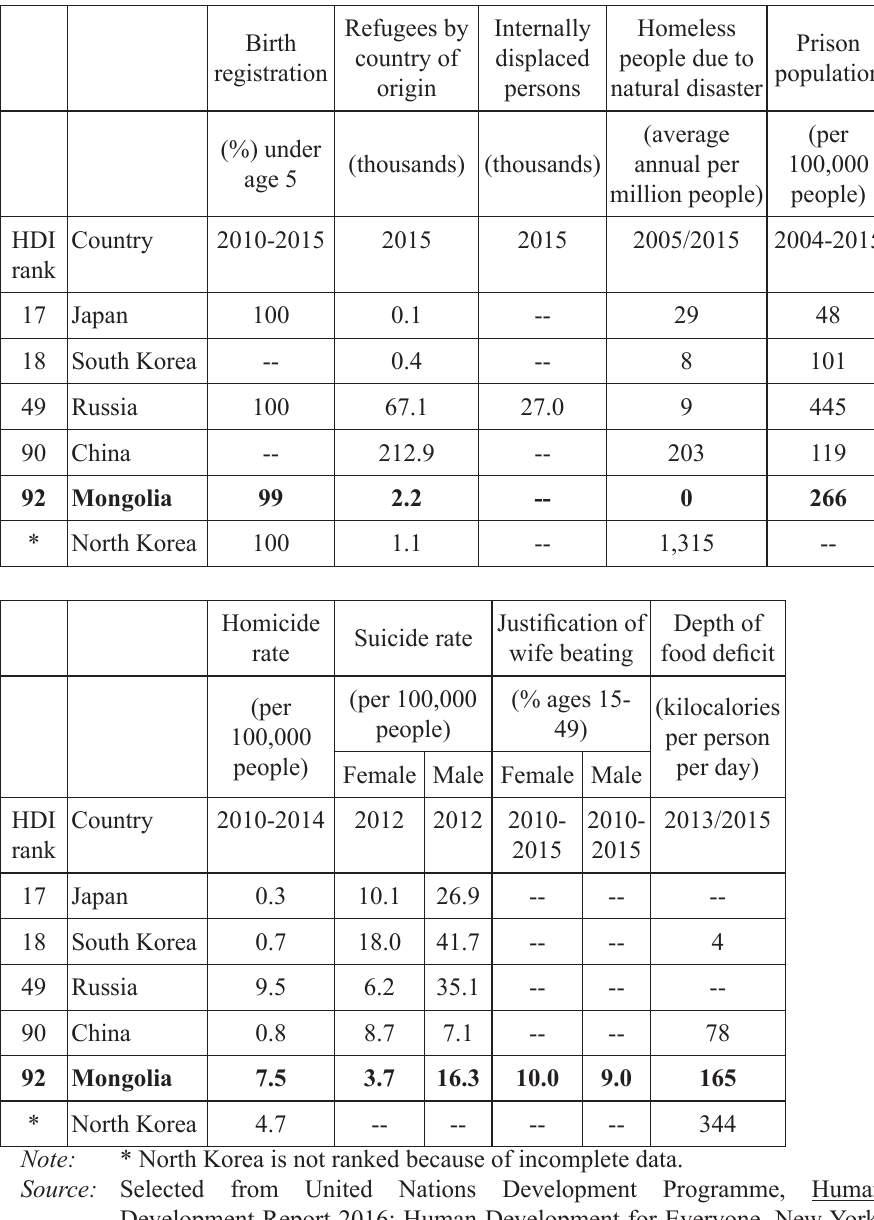
Table 7. Human security in Northeast Asian countries Refugees by Internally Homeless Birth Prison country of displaced people due to population origin persons natural disaster (thousands) (thousands)